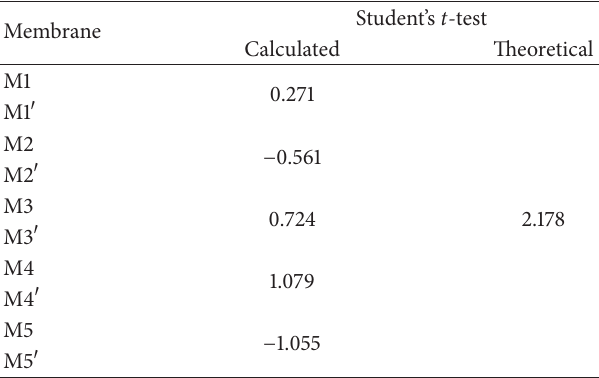
Table 3: Student’s t -test parameter values for the membrane systems.